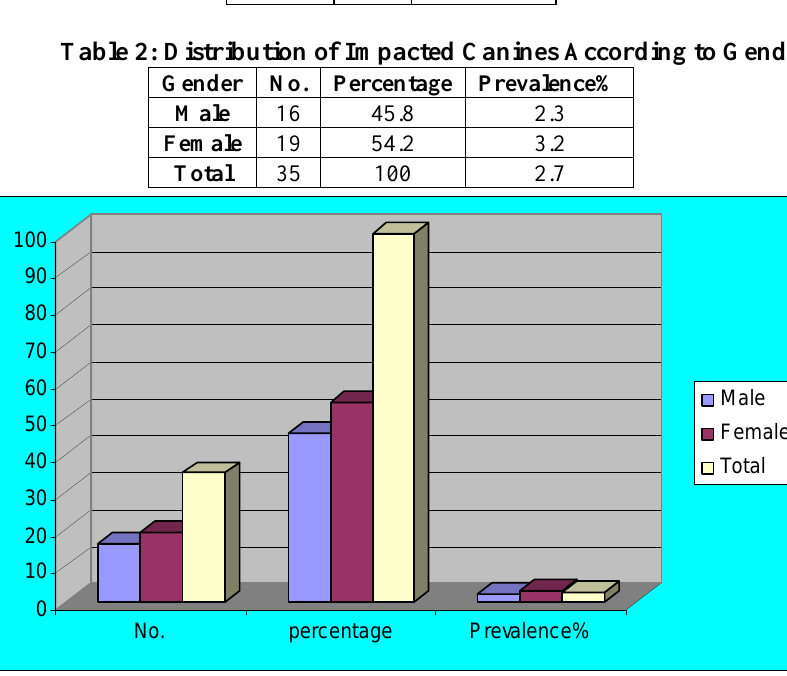
Figure 3: Distribution of Impacted Canines According to